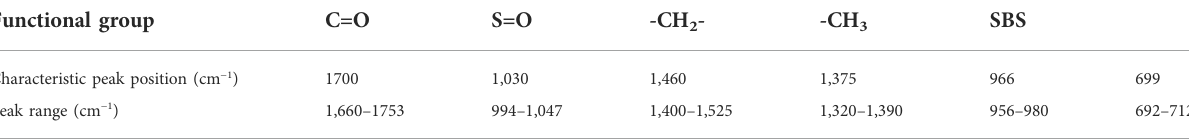
TABLE 5 Position and range of characteristic peaks for each functional